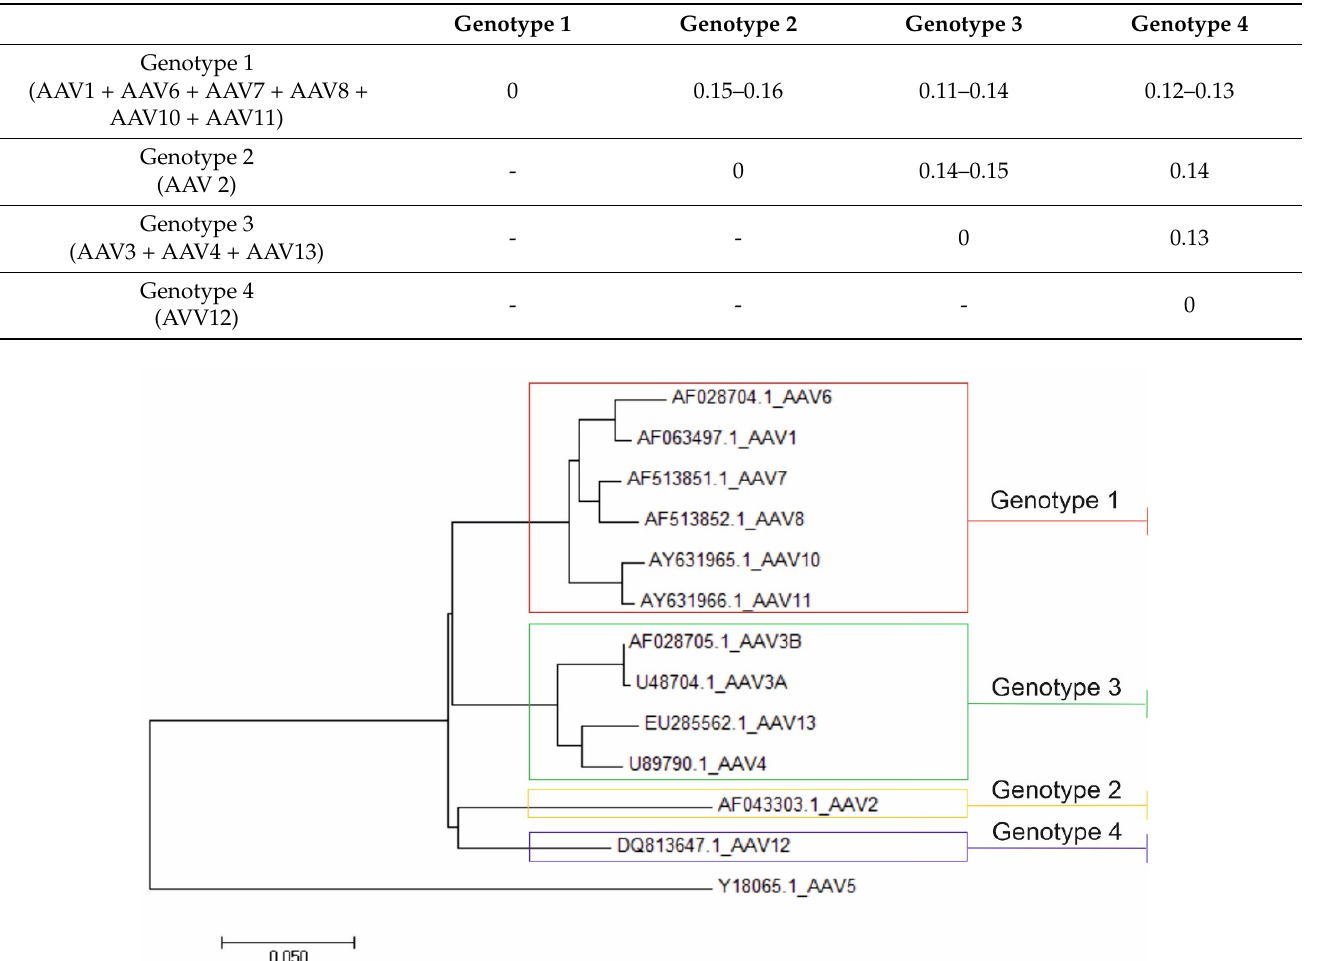
Figure 4. Neighbor-joining phylogenetic tree for the 453–1700 nt region of the AAV A genome. Correlations of currently registered serotypes and four suggested genotypes are presented. AAV B represents an outgroup.